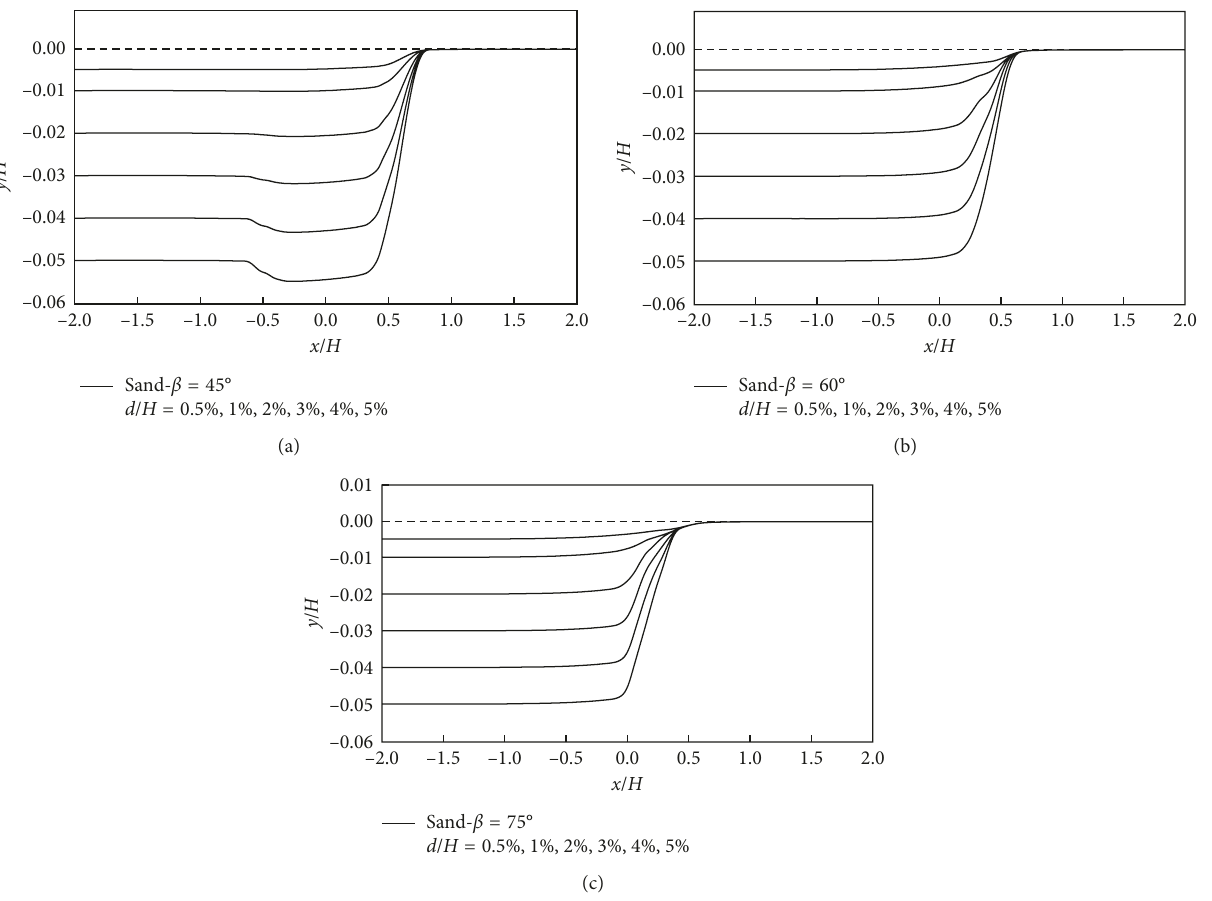
Figure 7: The ground displacement curves with different dip angles for the normal fault in sand: (a) 45 ° , (b) 60 ° , and (c) 75 °